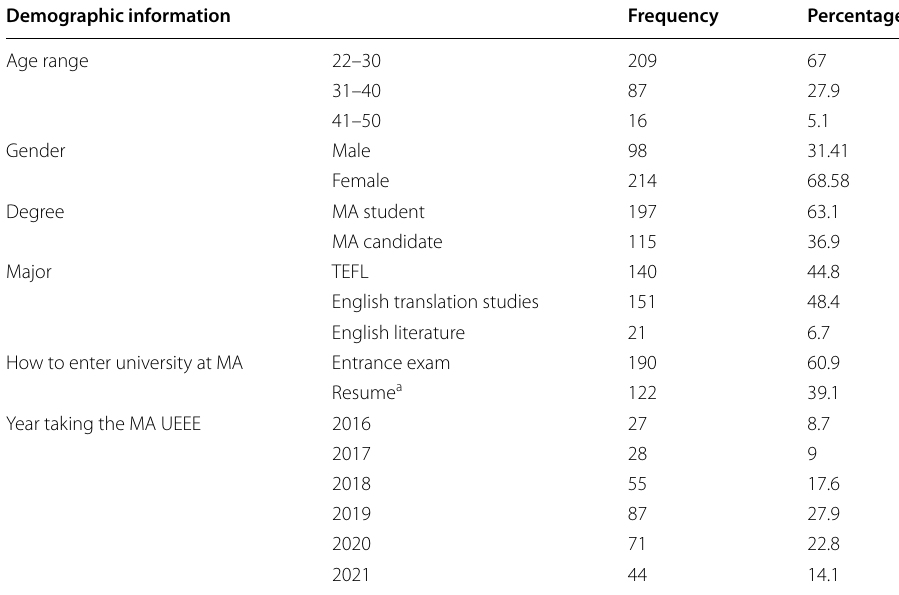
Table 2 Demographic information of the participants in the final administration